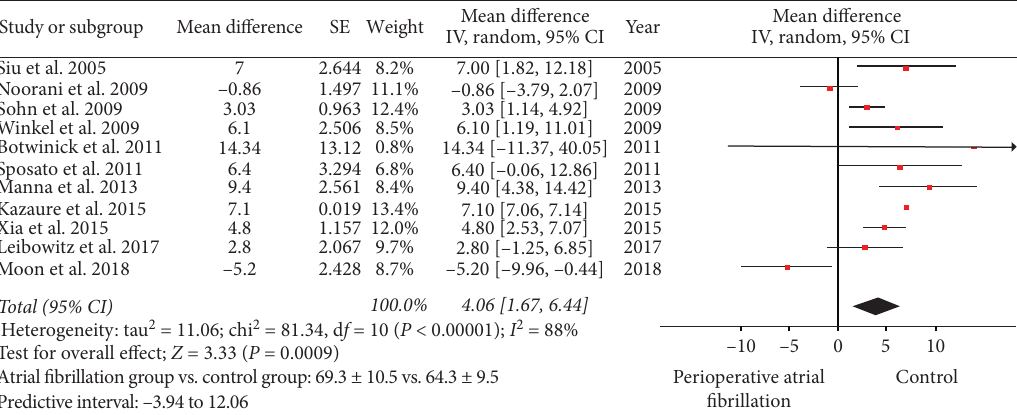
Figure 2: Forest plot evaluating age as a risk factor for perioperative atrial fibrillation in patients undergoing noncardiothoracic surgery. The mean difference of each included study is plotted. A pooled estimate of overall mean difference (diamonds) and 95% confidence intervals (width of diamonds) summarizes the effect size using the random effects model. CI � confidence interval; IV � inverse variance; MD � mean difference; I 2 : heterogeneity; P < 0 . 05 is significant.